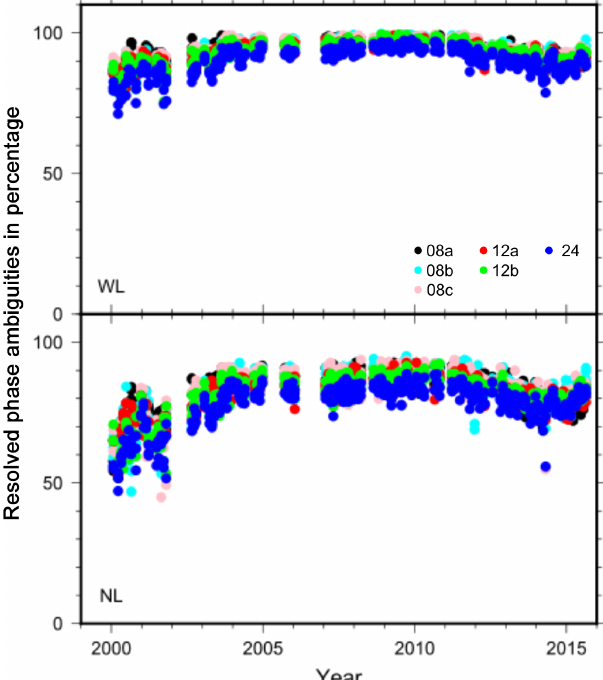
Figure 2. Daily fixed phase ambiguity resolution in percentage. WL is wide-lane ambiguity resolution and NL is narrow-lane ambiguity